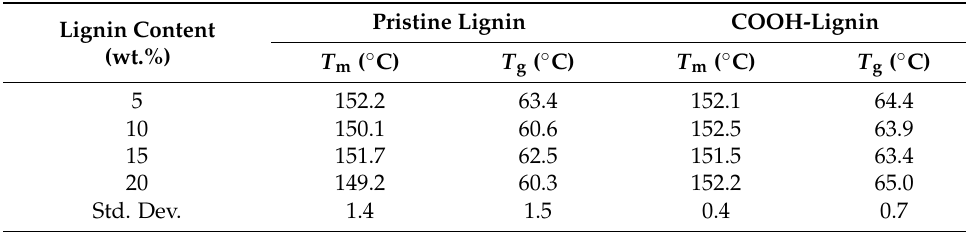
Table 1. The melting temperatures ( T m ) and glass transition temperatures ( T g ) of poly(lactic acid) (PLA)-based biocomposites with pristine lignin and COOH-lignin content. Pristine Lignin Lignin Content (wt.%)